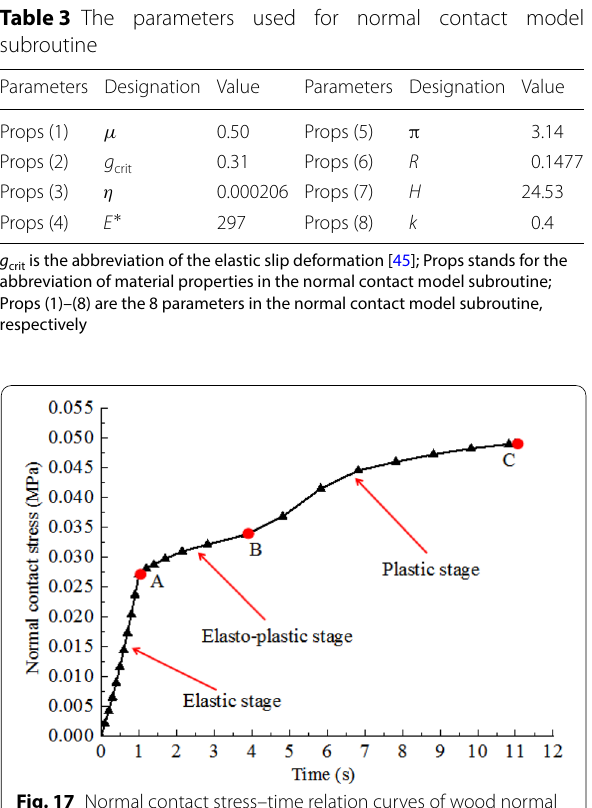
Comparisons between experimental and numerical results Figure 17 draws the normal contact stress and analy- sis step time relation curve of wood contact surfaces